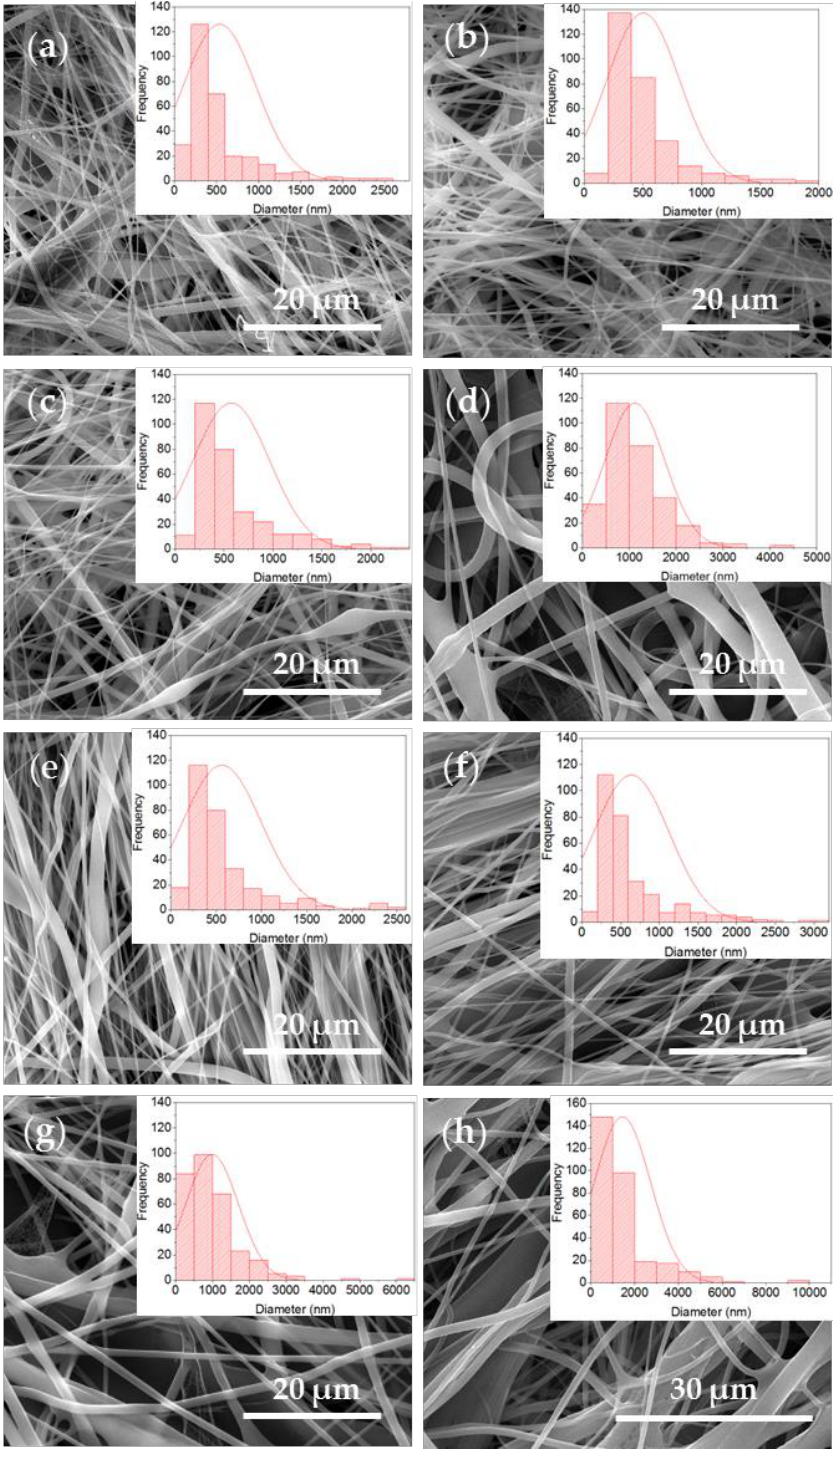
Figure 5. SEM images and histogram of fiber diameter distribution of the R-P/G-EPnF and A-P/G-EPnF meshes. ( a ) R-P/G0-EPnF, ( b ) R-P/G0.5-EPnF, ( c ) R-P/G1-EPnF, ( d ) R-P/G2-EPnF, ( e ) A-P/G0-EPnF, ( f ) A-P/G0.5-EPnF, ( g ) A-P/G1-EPnF, and ( h ) A-P/G2-EPnF.